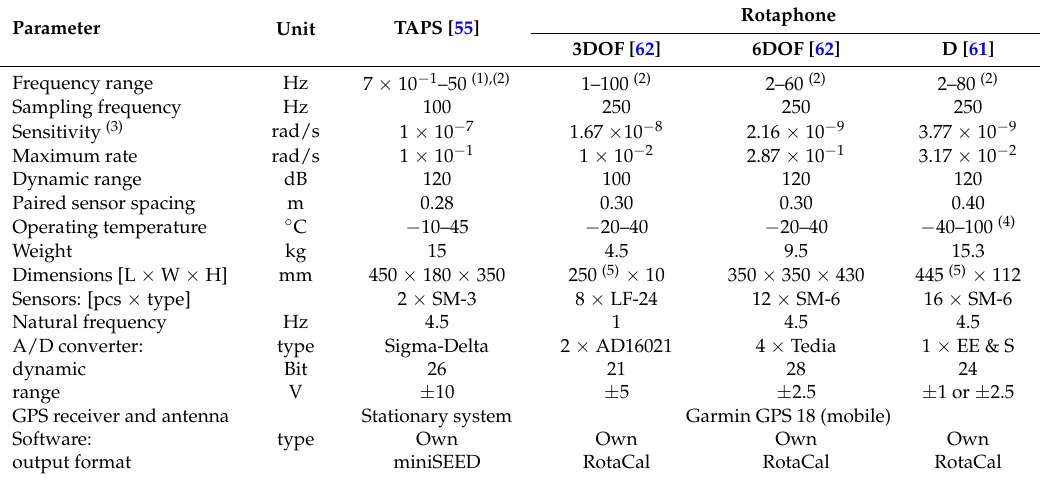
Table 1. Overview of rotational seismometers using indirect measurement (only the most important parameters are listed).